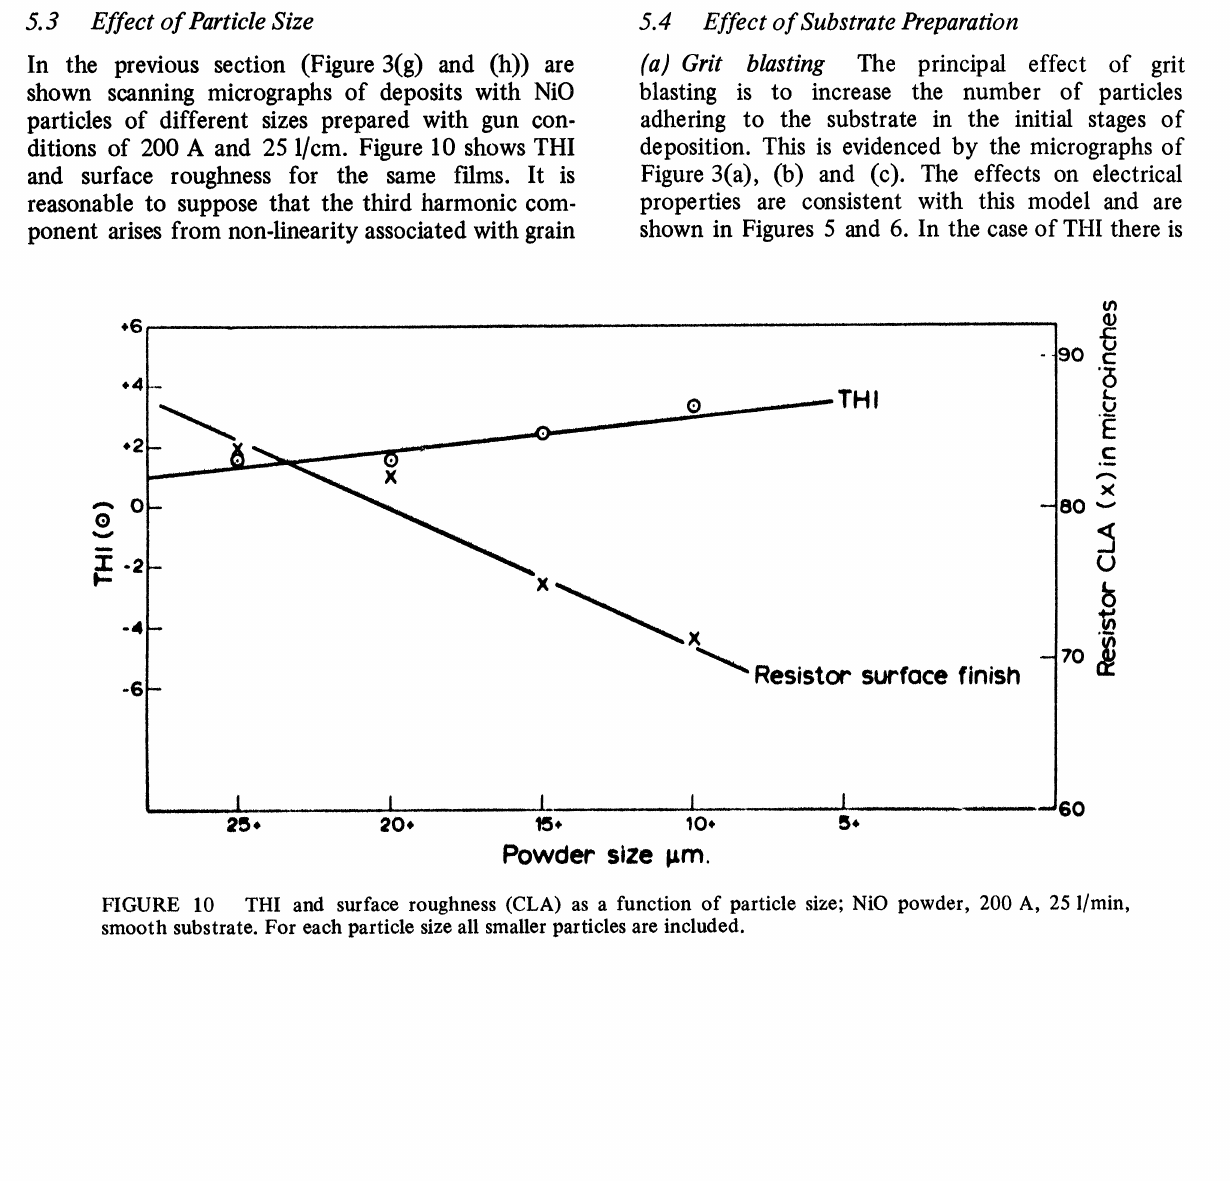
THI and surface roughness (CLA) as a function of particle size; NiO powder, 200 A, 25 l/min, smooth substrate. For each particle size all smaller particles are